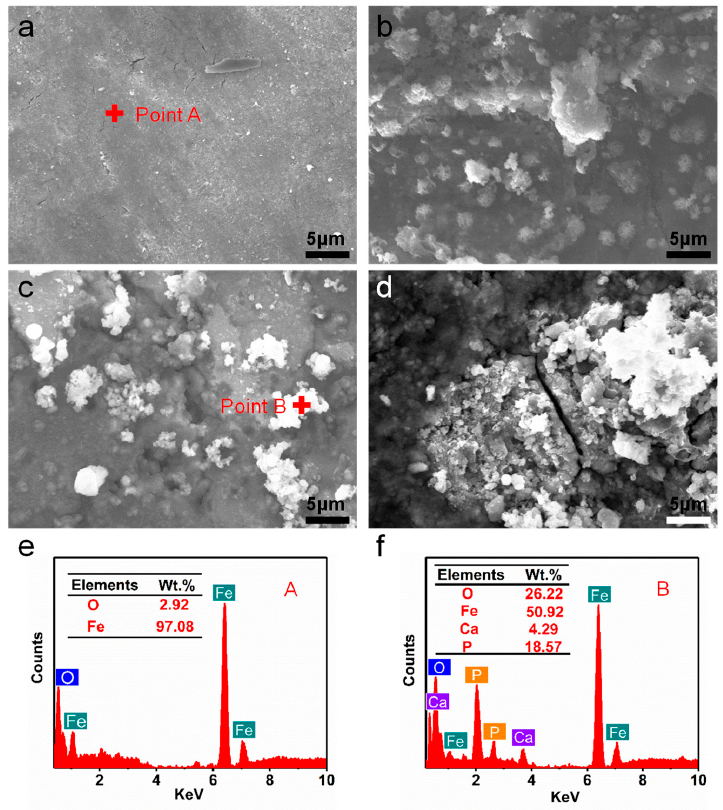
Figure 7. Corrosion surface of ( a ) Fe, ( b ) Fe/0.5MC, ( c ) Fe/1.0MC and ( d ) Fe/1.5MC composites after immersion for 21 d; ( e ) and ( f ) were the corresponding EDS analyses of points A and B, respectively.